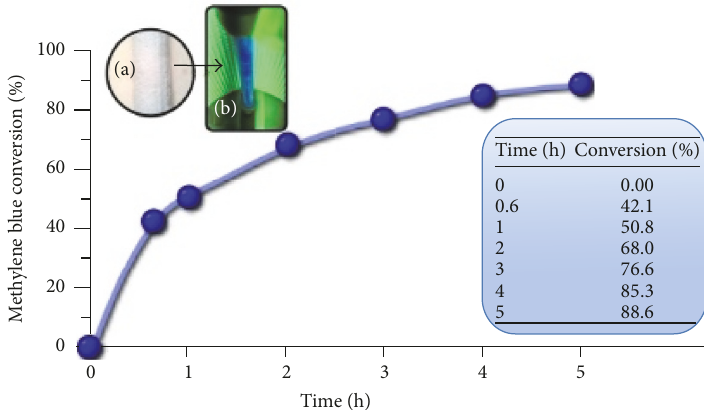
Figure 11: Temporal evolution of MB removal during photocatalytic experiments under UV light irradiation using 3D printed supports fabricated with the second route (Section 2.2). The inset image shows (a) the 3D printed support covered with the photocatalyst TiO 2 and (b) the photoreactor filled with the 3D structures and recirculating